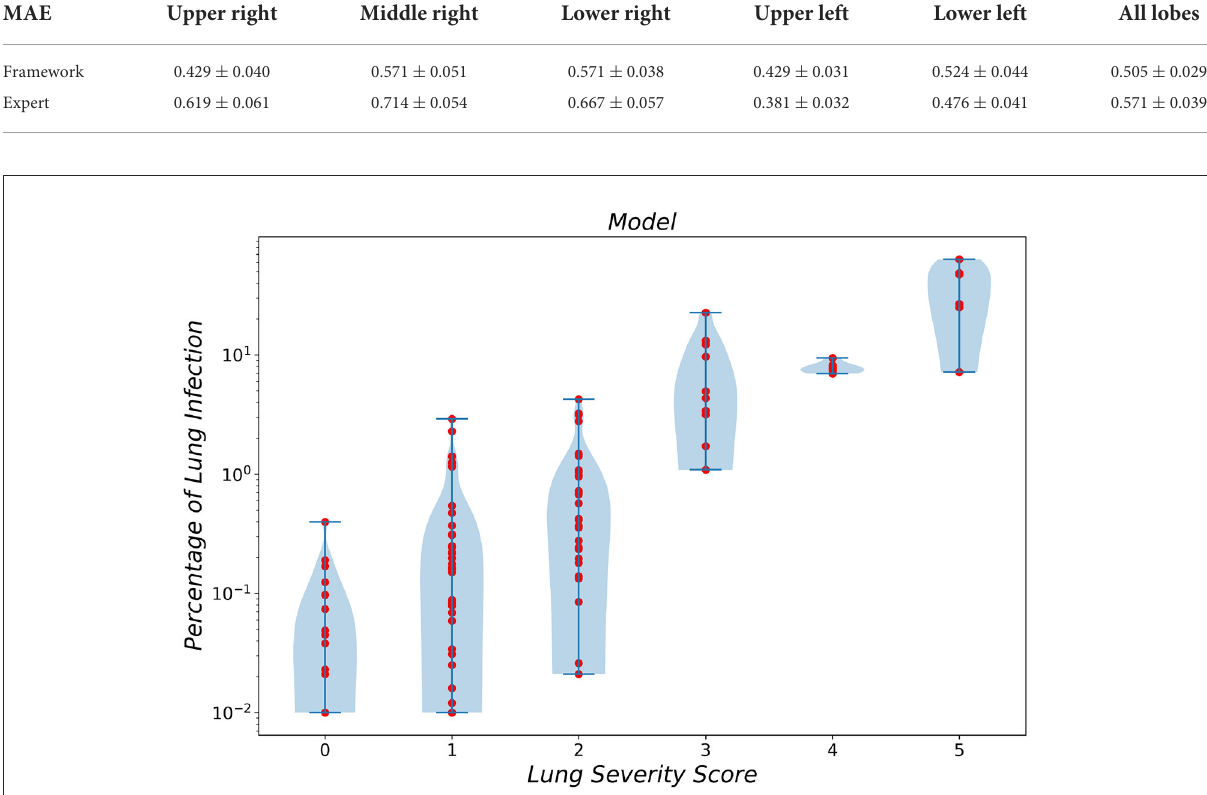
FIGURE5 Violin plot of infection severity percentage predicted by the framework for 6 different classes.